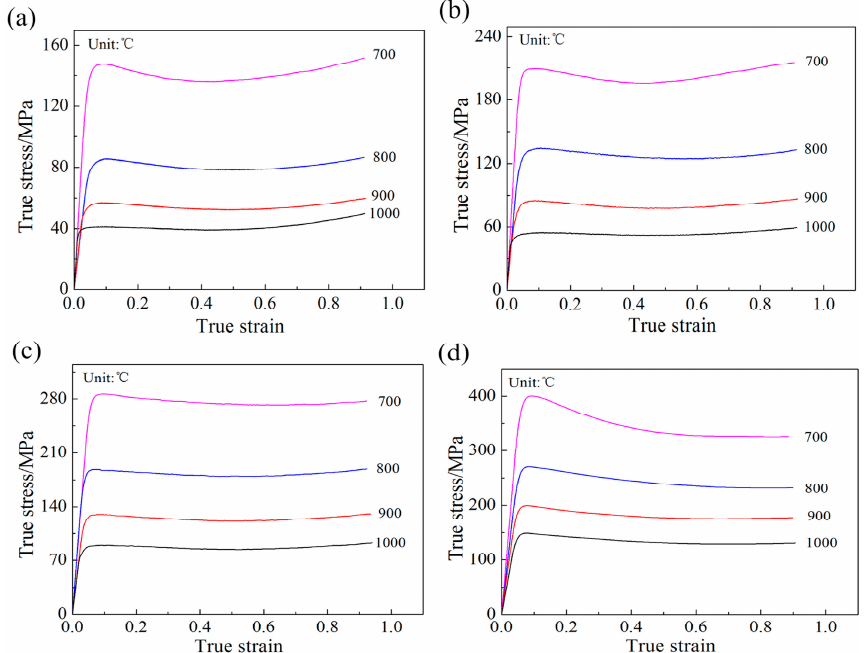
Figure 3. True stress-strain curves of NiTiNb SMA undergoing uniaxial compression based on the various temperatures and strain rates: ( a ) various temperatures and strain rates: ( a ) . ε = 0.5 s − 1 .